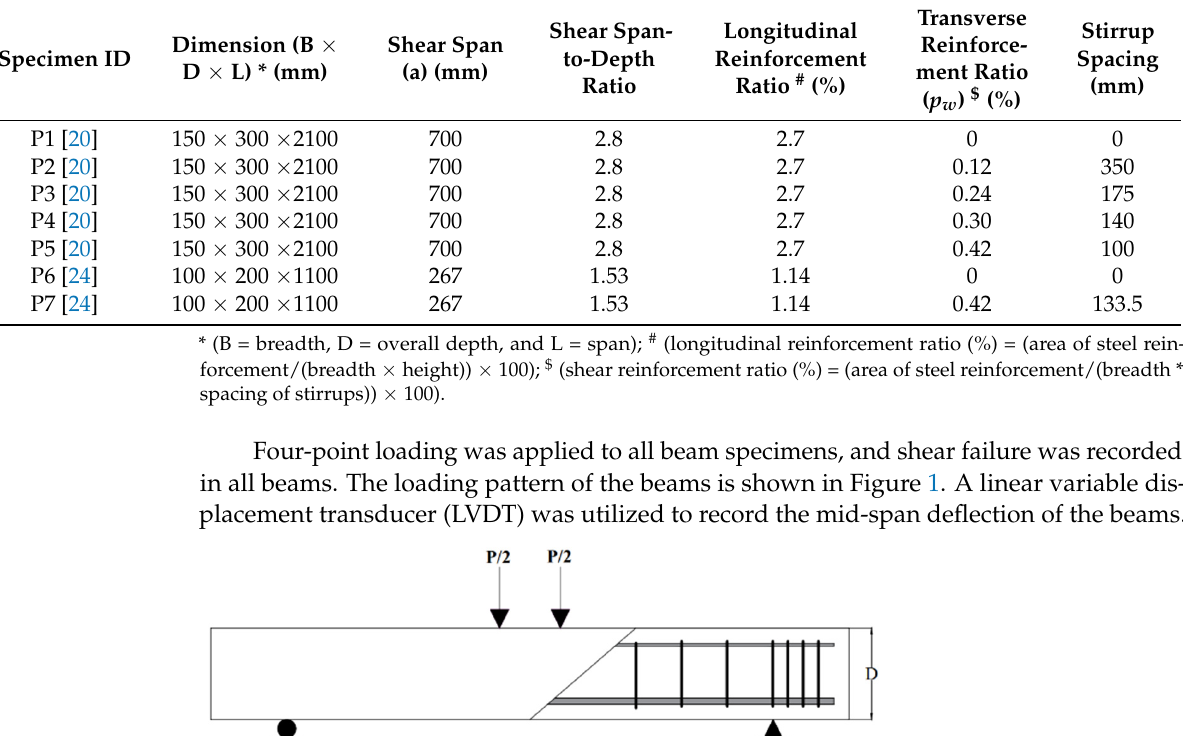
Table 1. Specifications of beams.